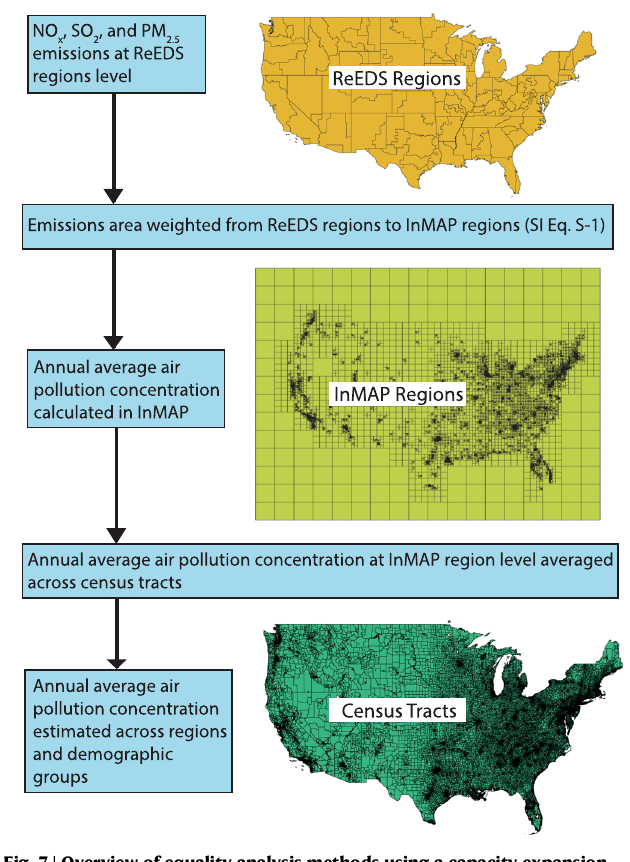
Fig. 7 | Overview of equality analysis methods using a capacity expansion model (ReEDS) and a reduced complexity air pollution transport model (InMAP) to investigate where emissions are settling after being emitted from power plants. Regions are downscaled from ReEDS regions to census tract level, and annual average air pollution concentrations are estimated from emissions at theReEDSregionlevel.FigureS-2showsInMAPemissioninputs.The shape fi lesfor the maps produced in this image are sourced from NREL ReEDS 5 , InMAP output fi le 52 , and ArcGIS 64